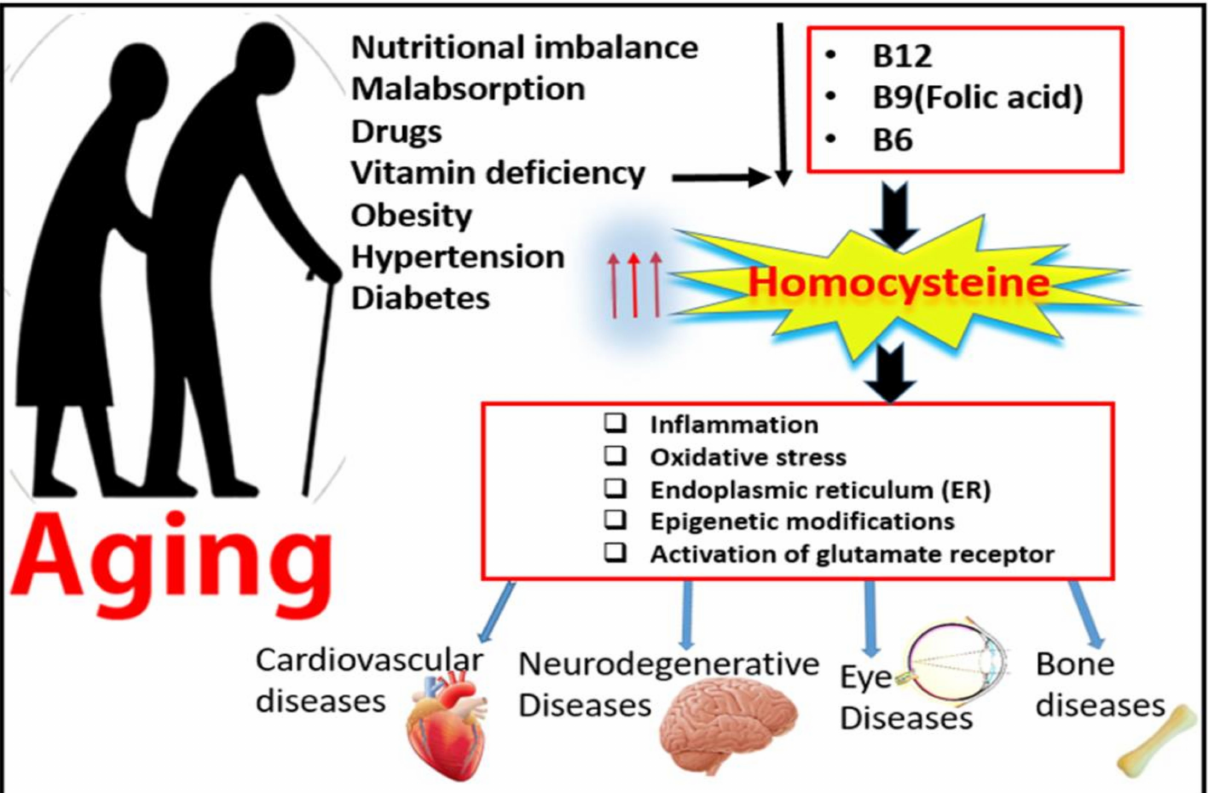
Figure 1. Effect of aging on homocysteine metabolism and possible mechanisms of hyperhomocysteinemia-associated aging